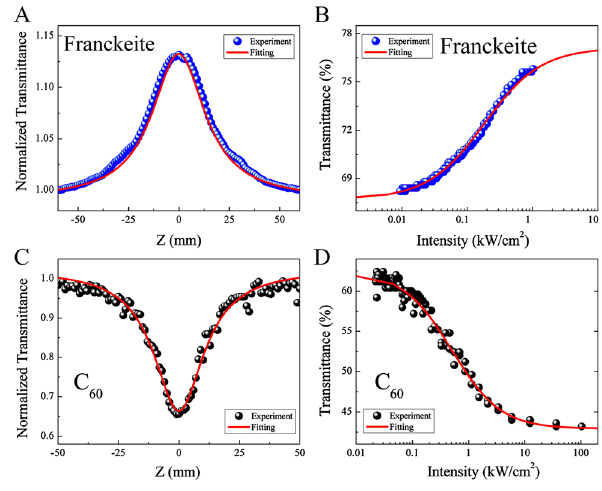
Figure 2: Nonlinear optical characteristics of layered franckeite and C 60 . Open aperture (OA) Z-scan curves of (A) franckeite and (C) C 60 at 1064 nm wavelength, respectively. The corresponding relationship between transmittance and input intensity of (B) franckeite and (D) C 60 , respectively.